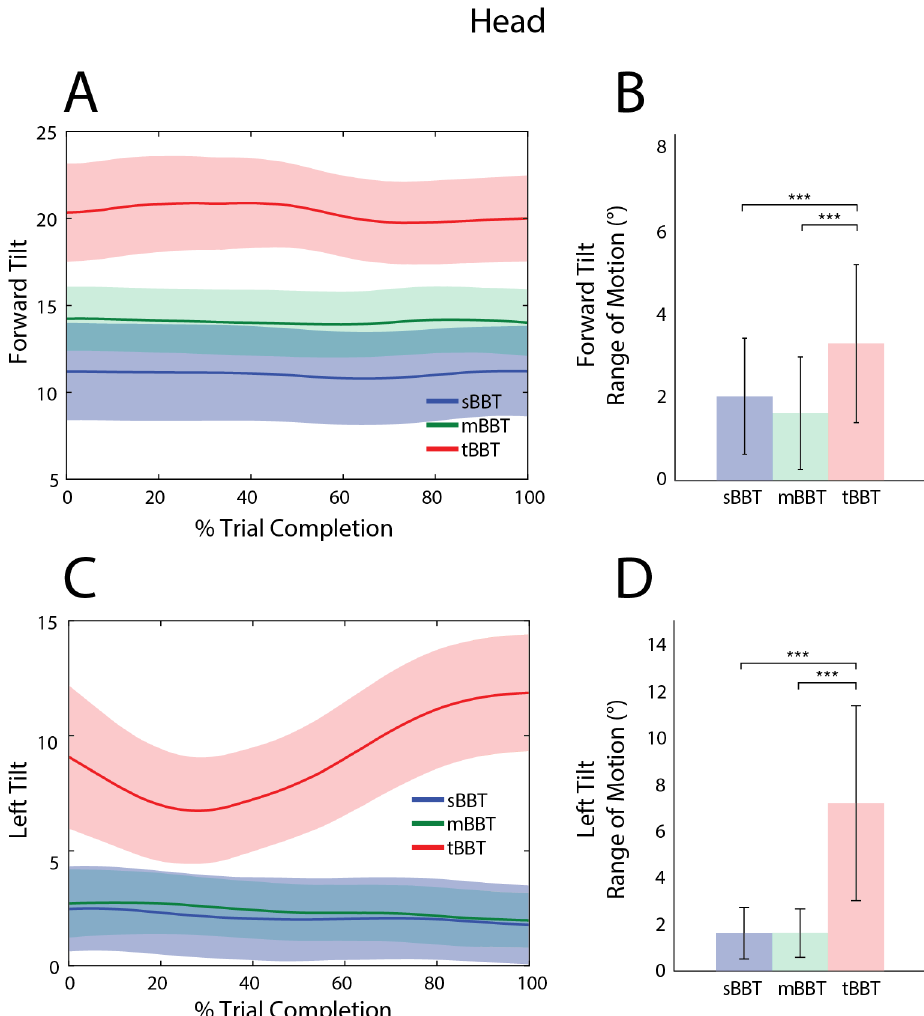
Fig 7. Kinematic trajectories and RoM of the head. Kinematic trajectories and RoM of the headfor the sBBT (blue), mBBT (green), and tBBT (red). (A) Forward tilt and (C) left tilt trajectories for each test. (B) Forward tilt RoM and (D) left tilt RoM for each